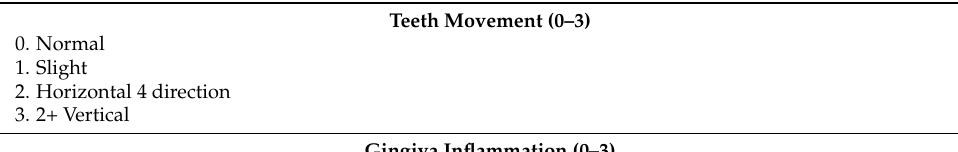
Table 1. Screening of oral condition. If either items two or three in these check criteria apply, the patient should be instructed to go to an oral surgery clinic in our hospital, and the details should be reported to the